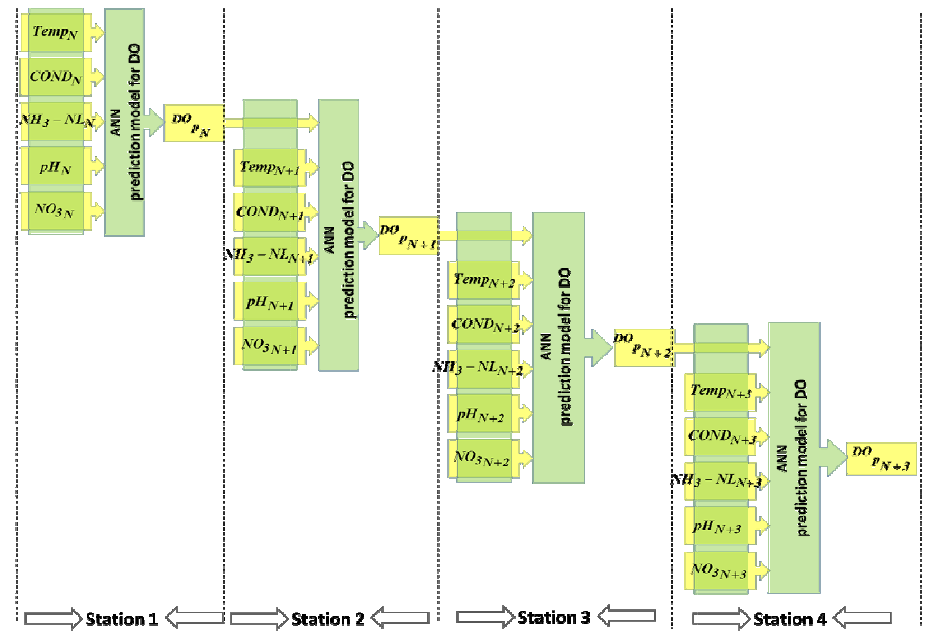
Fig. 3: A schematic chematic representation for Scenario 2 Fig. 3. A schematic representation for Scenario